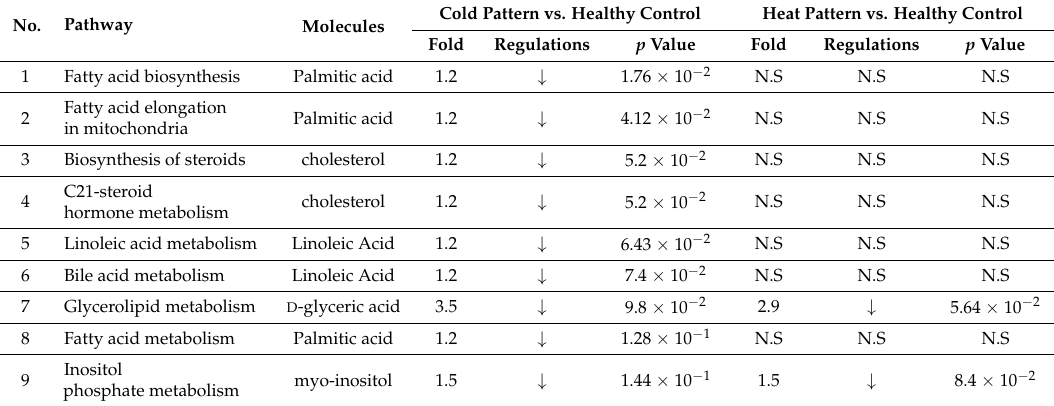
C21-steroid hormone metabolism , linoleic acid metabolism , bile acid metabolism , and fatty acid metabolism . Table 3. Comparison of cold pattern vs. healthy control and heat pattern vs. healthy control in lipid metabolism ( ↓ , downregulation, N.S, no